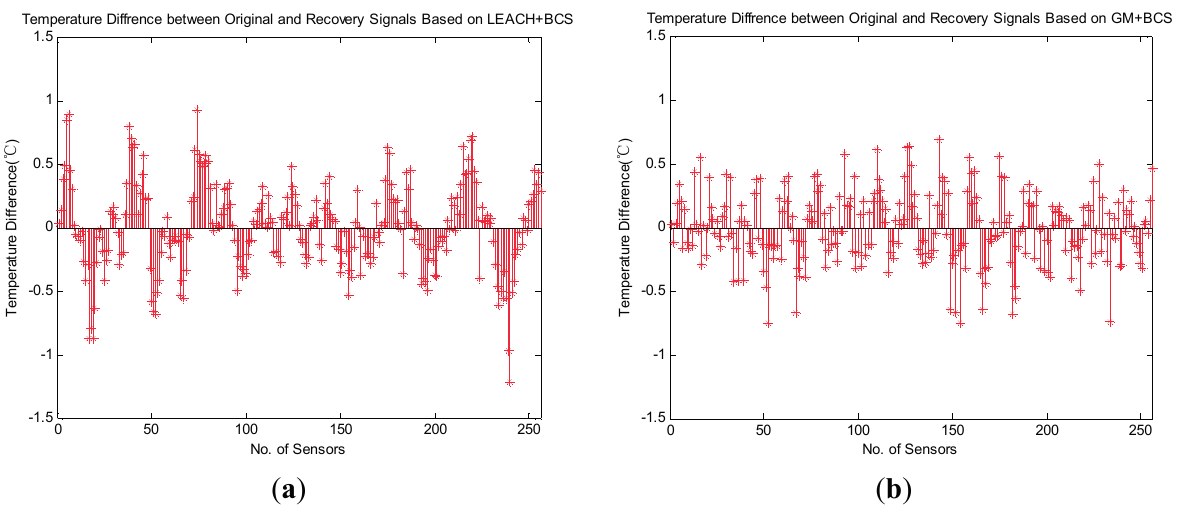
Figure 11. Experimental results of the original and recovered signals with HRM_CS1 and